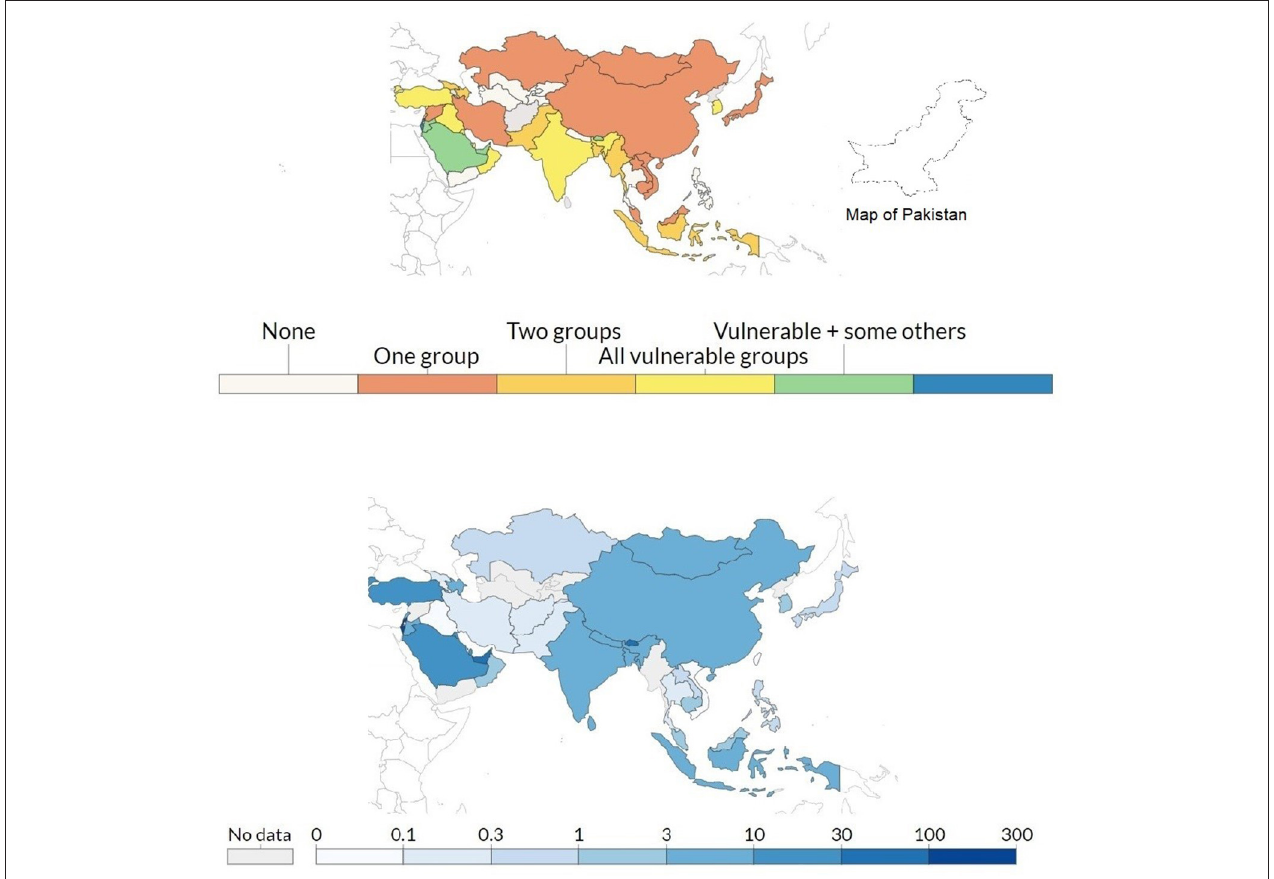
FIGURE 3 | Top : Metric records policies in Asian countries for vaccine delivery for three groups: (i) keyworkers, (ii) clinically vulnerable, and (iii) the elderly. Here one means to ensure the supply of the vaccine to one of the three groups, two means to ensure that two of three groups receive the vaccine, while three means ensuring that all groups receive the vaccine equally. Bottom : Metric record of the total number of vaccination doses administered per 100 people in the total population. This data counted as a single dose, even though people have received two doses of the vaccine (opensource: